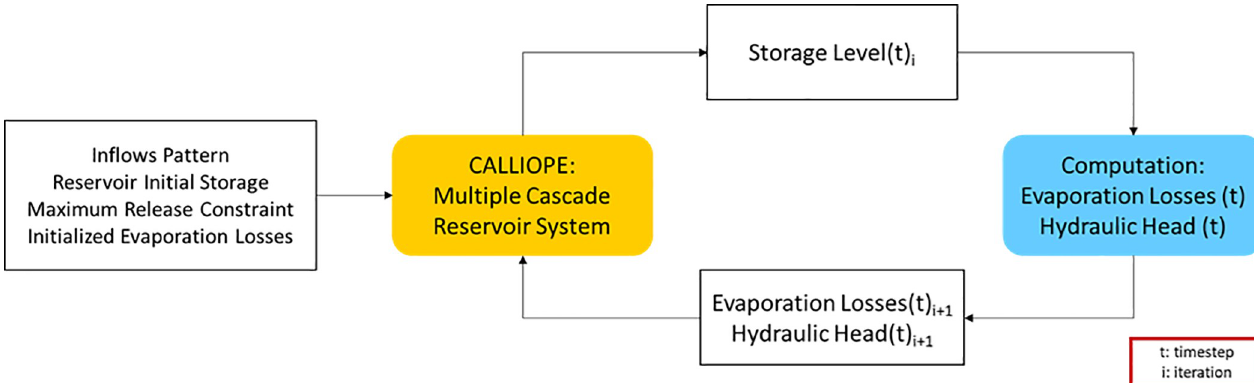
Fig 2. Logical scheme for the iteration of the Calliope_Hydro